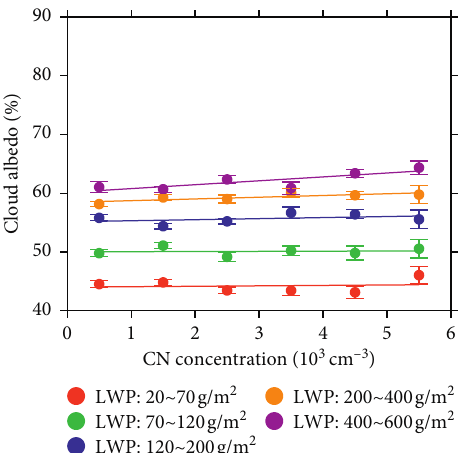
Figure 7: Cloud albedo as a function of condensation nuclei concentration number (CN) for shallow warm clouds over the SGP site. Data are binned according to LWP. Error bars show the standard